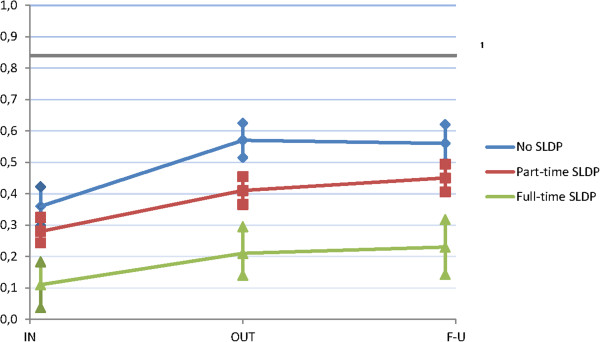
Health related quality of life (HRQoL) measured by EQ-5D. Mean HRQoL at multimodal rehabilitation (MMR) start (IN), completed MMR (OUT) and at three month follow-up (FU), in patients with no (n = 123), part-time (n = 214) or full-time (n = 69) sick leave/disability pension (SLDP) the year before MMR. 1 EQ-5D = 0.84, a Swedish normal population in two counties. 95% confidence interval (CI).